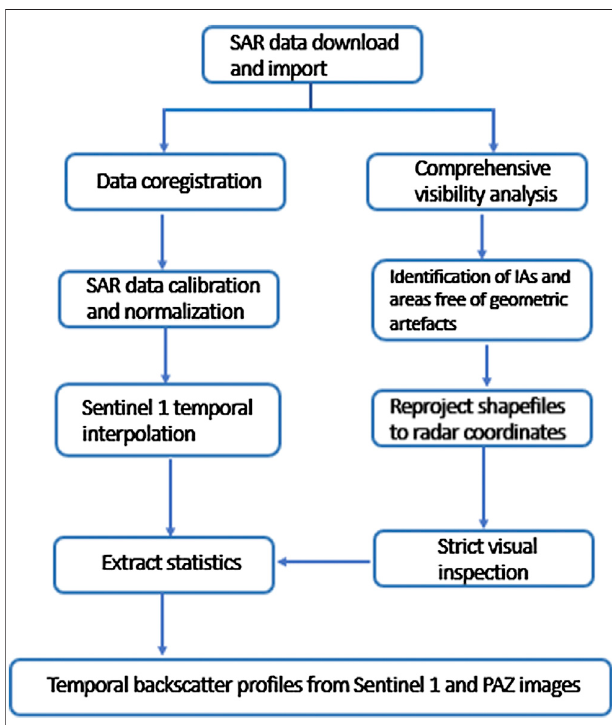
FIGURE 4 | Flowchart of the processing